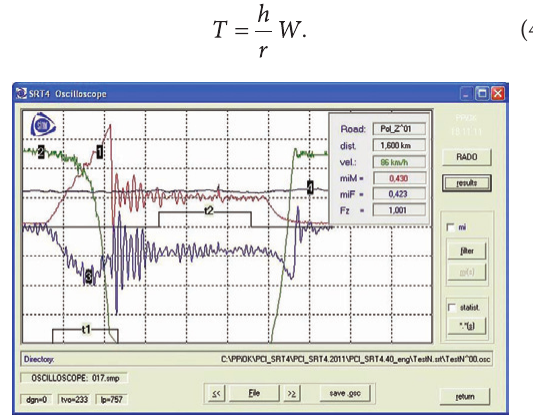
fig. 3. Exemplary results obtained during braking process (view of the screen): 1 – braking torque Wh ; 2 – wheel velocity ω; 3 – wheel friction force T ; 4 – wheel normal load F z ; t 1 – time in which μ(s) adhesion characteristic is determined; t 2 – time in which average values of friction force are